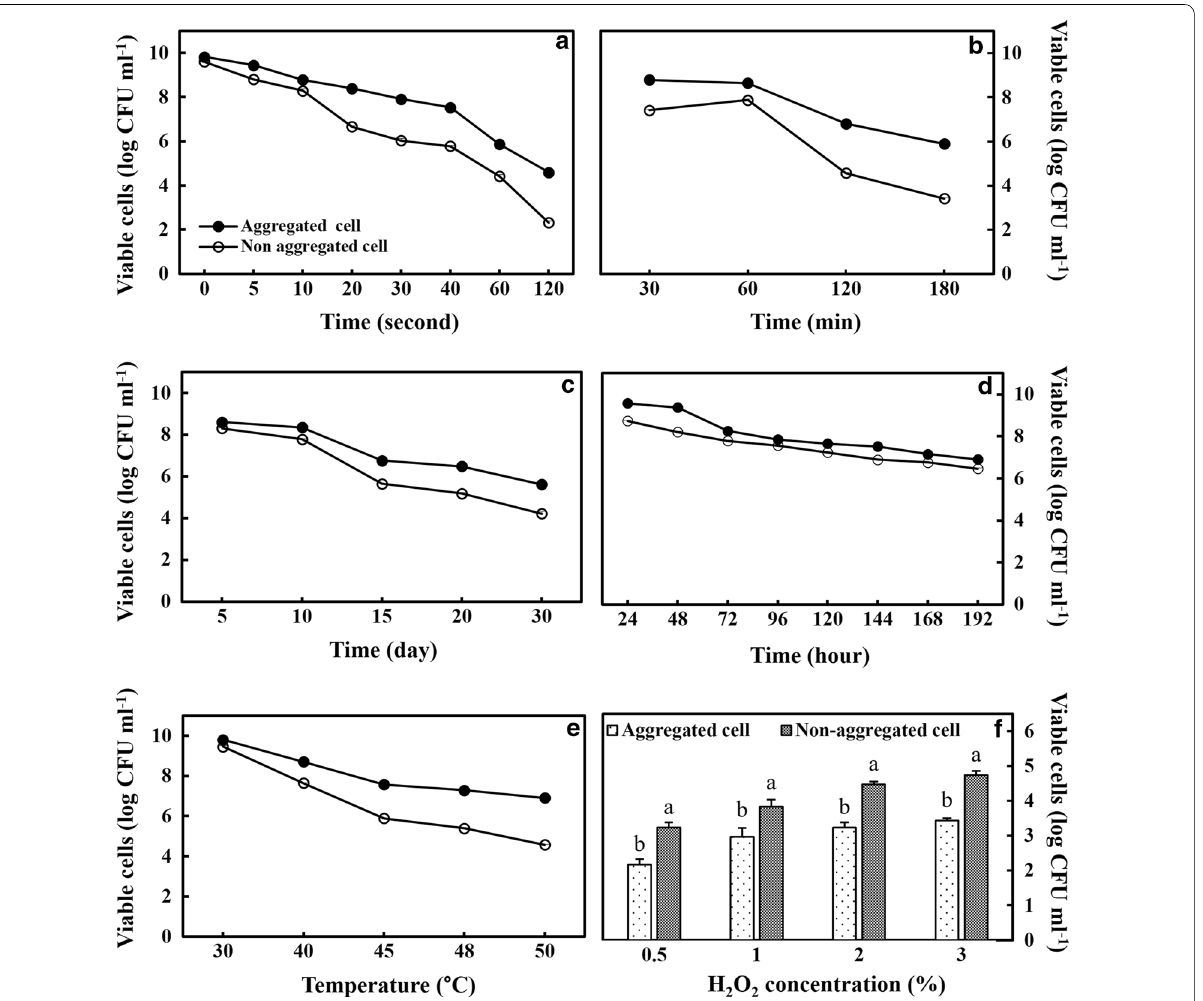
Fig. 1 The impact of various stresses on the growth of M. oryzae CBMB20. a UV irradiation. b Desiccation. c Starvation and d cold (4 °C). e Heat (30–50 °C), f oxidative (H 2 O 2 ). All data represents mean SE of three replicates and differences between means analyzed using DMRT test ( P ±